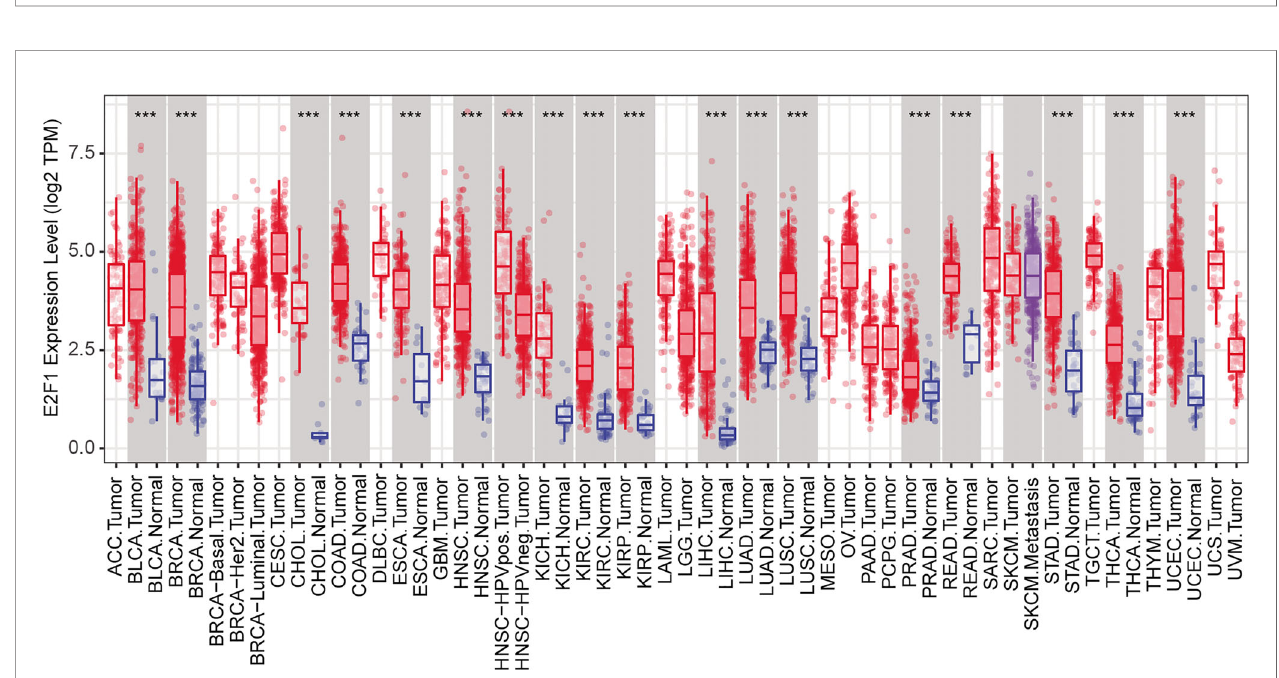
FIGURE 6 | The transcriptional regulatory network of DEGs involved in cell cycle, cell division, and cell proliferation. (A) The TF – target interaction network. (B) Heatmap of Pearson correlation coef fi cient between E2F1 and its targets. The correlation coef fi cient was calculated by the cor function in R packages. Only the pairs with absolute values ≥ 0.5 were shown and no negative correlation was detected. (C) Expression veri fi cation of E2F1 between human lung cancer cells and adjacent lung normal tissues by GEPIA2. *p.adj ≤ 0.05.